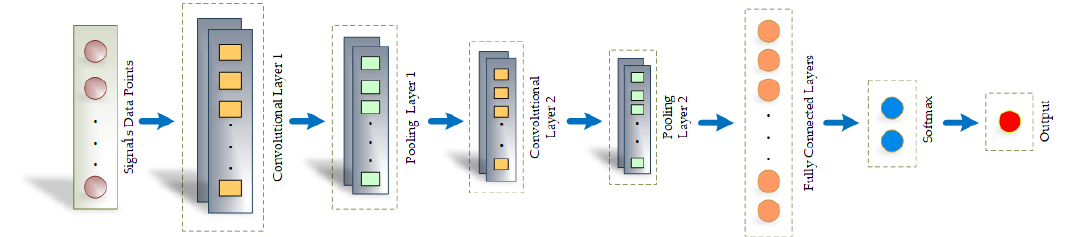
Figure 7. Discriminator Architecture with Convolutional Neural